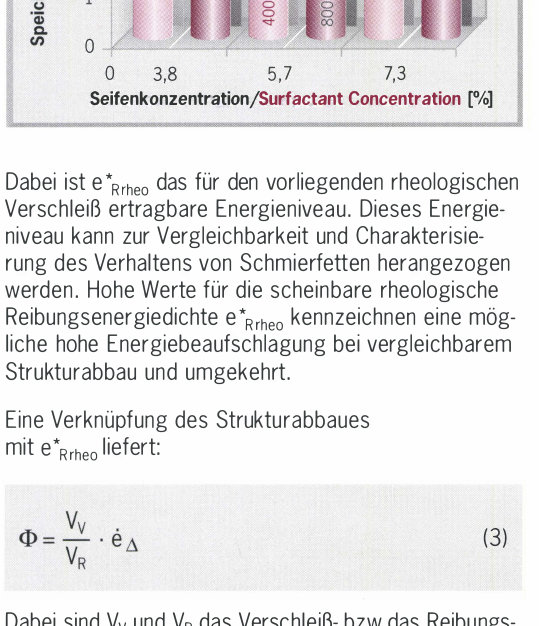
Fig. 4: Change in the storage modulus due to structural degradation